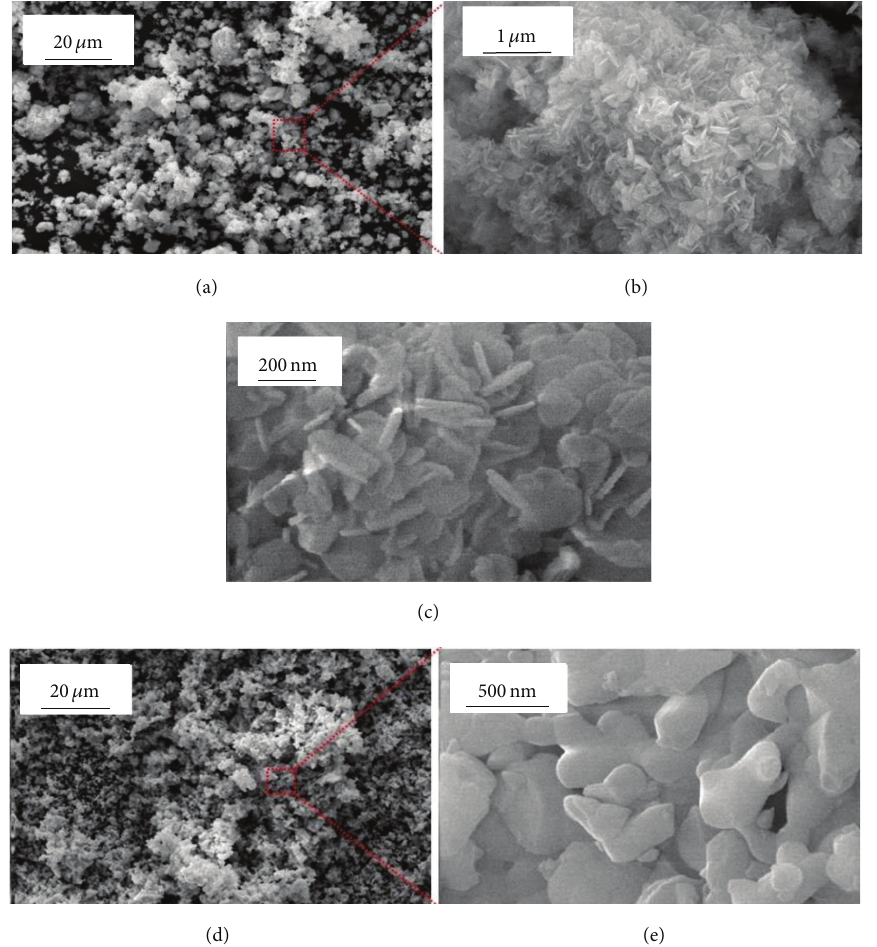
Figure 3: SEM images of the powders calcined at (a), (b), and (c) 450 ∘ C/1h; (d) and (e) 600 ∘ C/1h.